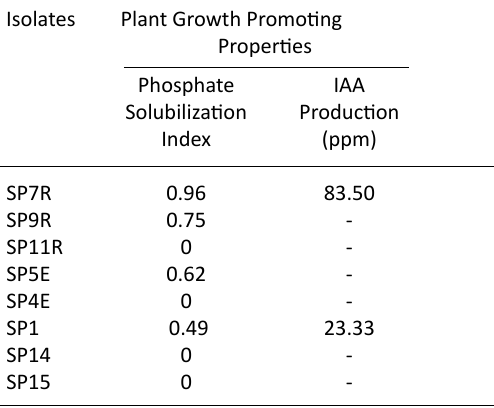
table 2. Plant growth promoting ability produced by antagonistic bacteria against F. oxysporum Isolates